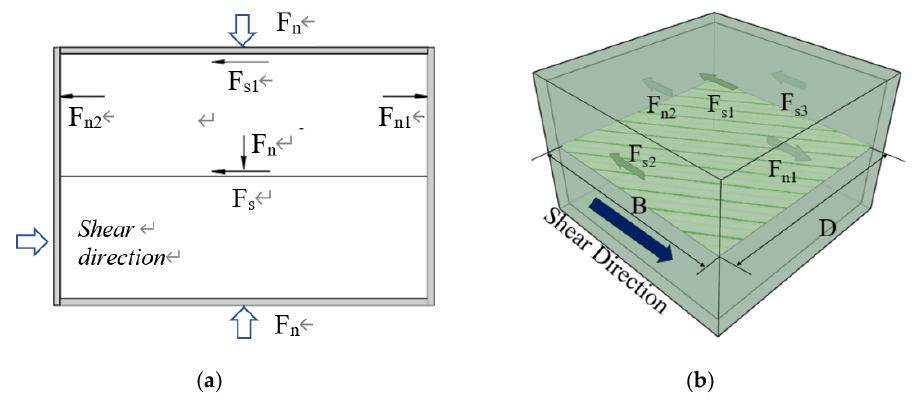
Figure 6. Schematic of the forces acting on the direct shear box in ( a ) 2D and ( b ) 3D. The forces acting on the shear box are shown in Figure 6b. The normal force ( F N ) acting on the shear plane is equal to the normal load applied to the assembly, whereas the shear force ( F S ) is equal to the sum of the horizontal forces in the upper section that can be calculated as follows. where F n 1 and F n 2 are the normal forces acting on the left and right walls of the box, F s 1 is the shear force on the top plate, and F s 2 and F s 3 are the shear forces on the front and back walls, as shown in Figure 6b. The normal and shear stresses σ n and σ s acting on the shear plane are calculated using Equations (8) and (9) below: